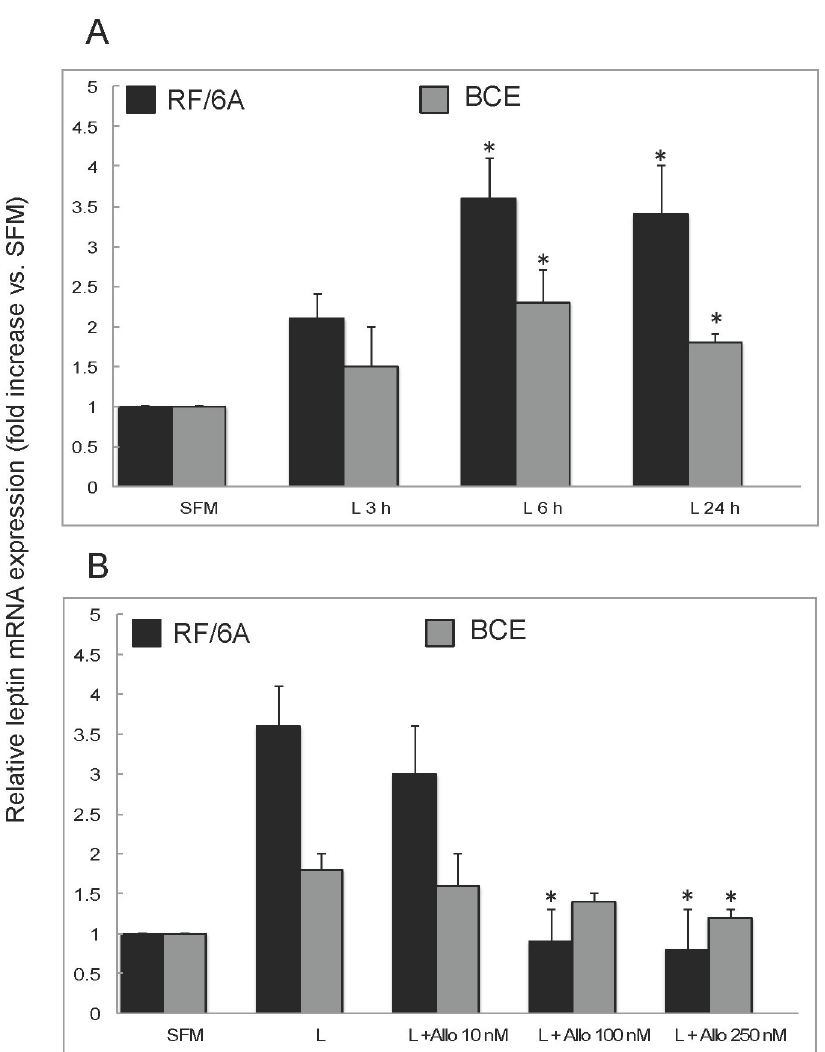
Figure 8. Effects of leptin and Allo-aca on leptin mRNA expression in RF/6A and BCE cells. A . RF/6A and BCE cells were stimulated with 250 ng/mL leptin (L) for 3, 6, and 24 h. The expression of leptin mRNA was assessed by QRT-PCR as described in Materials and Methods. The values represent fold increase (± SD) of leptin mRNA levels in leptin treated cells vs. untreated controls (C=SFM) assigned value 1. B . The cells were pretreated with 10, 100, or 250 nM Allo-aca (Allo) for 1 h and then stimulated with 250 ng/mL leptin (L) for 6 h. Leptin mRNA was measured by QRT-PCR. Asterisks indicate significant (p≤0.05) differences vs. SFM ( A ) or leptin ( B ).